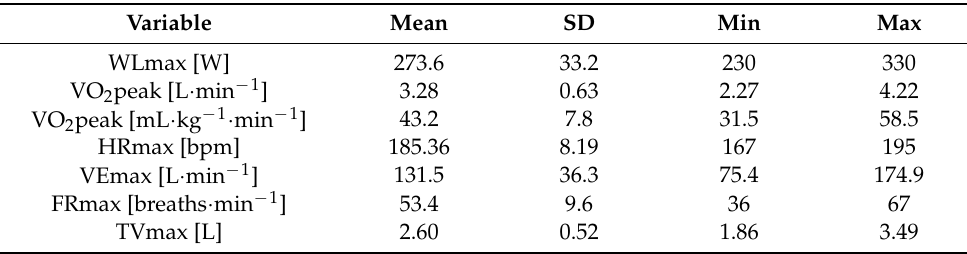
Table 2. Maximal values of variables measured in graded test. Variable Mean SD Min Max WLmax [W]